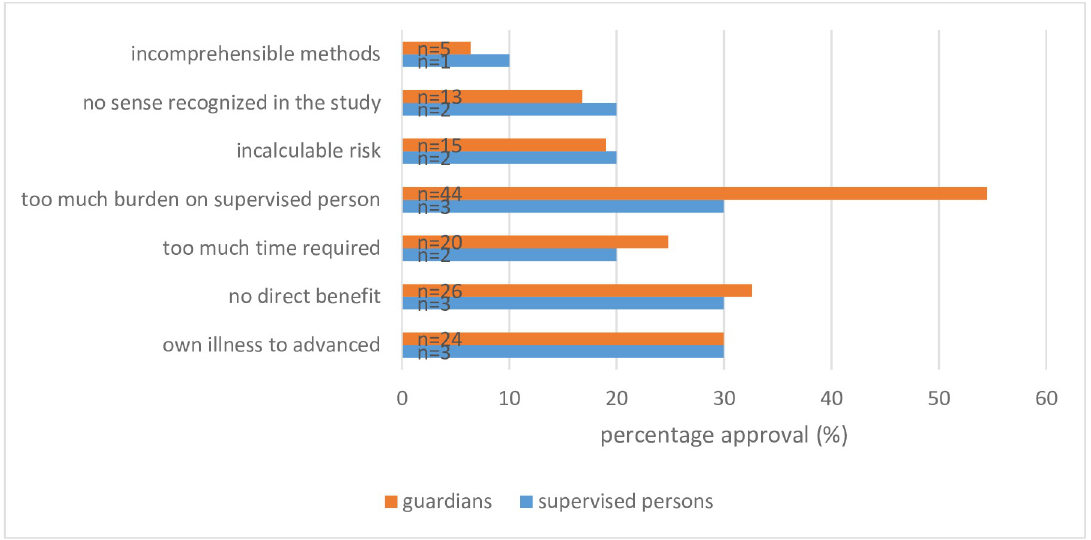
Fig 4. Reasons for disagreeing participation in a medical research project from the perspective of the guardians for each guardian- supervised patient-dyad separated (n = 80) and supervised persons (n = 10). Multiple answers were possible.